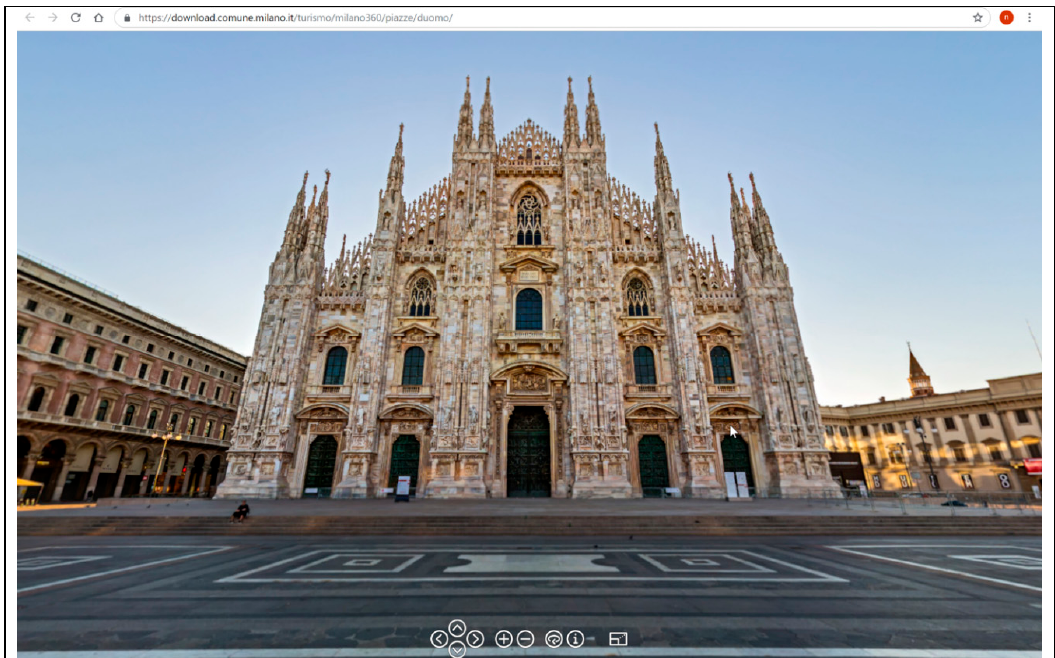
Figure A3. Milano @ 360—Duomo Square. Navigational command bar only [24].